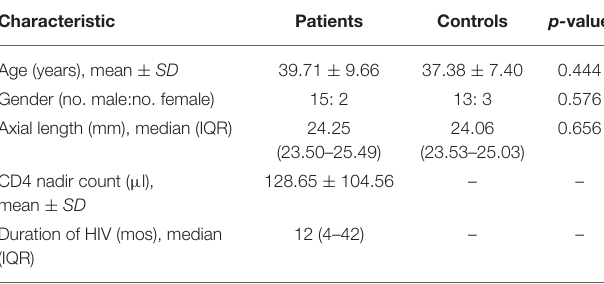
TABLE 1 | Demographic characteristics of patients included in the